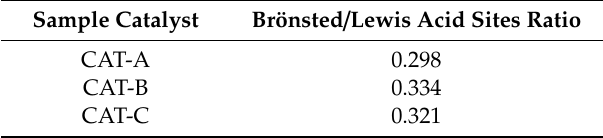
Figure 3. FTIR spectra shows IR band peaks for the catalysts A, B, and C studied. The black solid line represents pyridine adsorbed on CAT-A; the red solid line denotes pyridine adsorbed on CAT-B; and the blue solid line shows the pyridine adsorbed on CAT-C. Table 3. Brönsted / Lewis acid site ratios using pyridine FTIR.